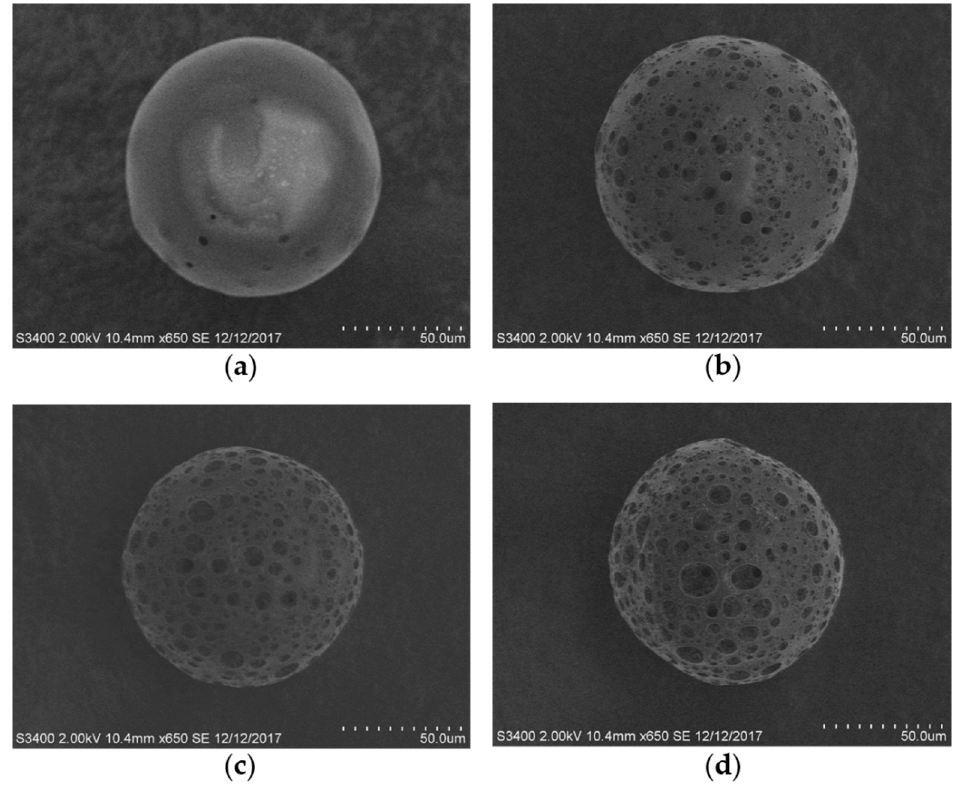
Figure 1. Scanning electron microscopy images of porous poly(lactide- co -glycolide) (PLGA) microspheres (MS) from ( a ) F1, ( b ) F2, ( c ) F3, and ( d ) F4. MS were fabricated as stable spheres. Larger pores were formed as the concentration of ammonium bicarbonate increased, due to its ability to generate gas inside MS.